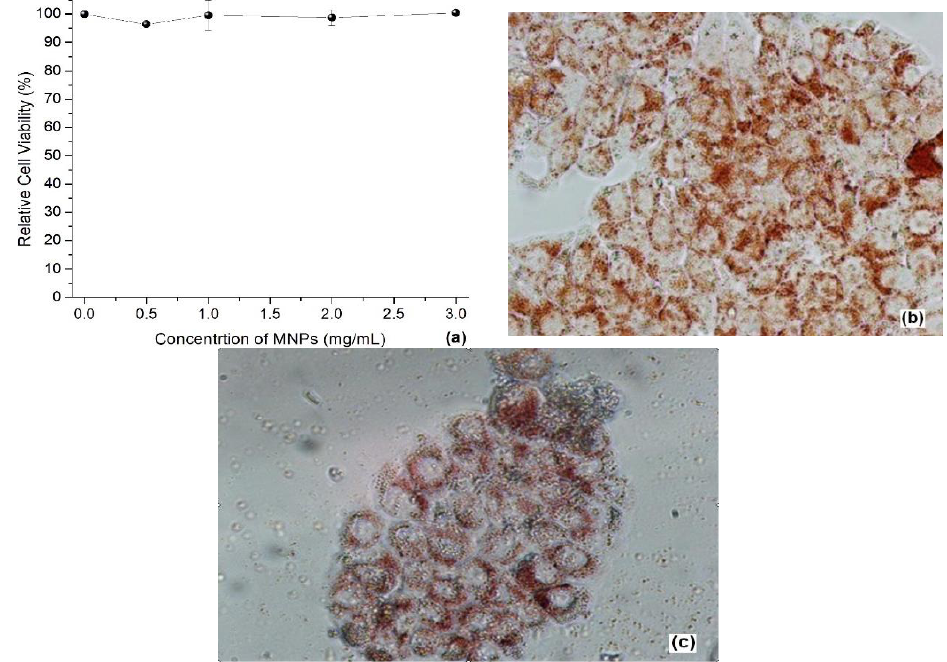
Figure 8. ( a ) Metabolic activity of HT-29 cells quantified as the relative WST activity when they were exposed to MNP-GA2 ferrofluid. Growth control activity was set to 100% for each experiment. Neutral red uptake of HT-29 after 24 h exposure to MPN-GA2: ( b ) Growth control (10 × magnification); ( c ) cells exposed to γ = 3.0 mg/mL of MPN-GA2 (40 × magnification).